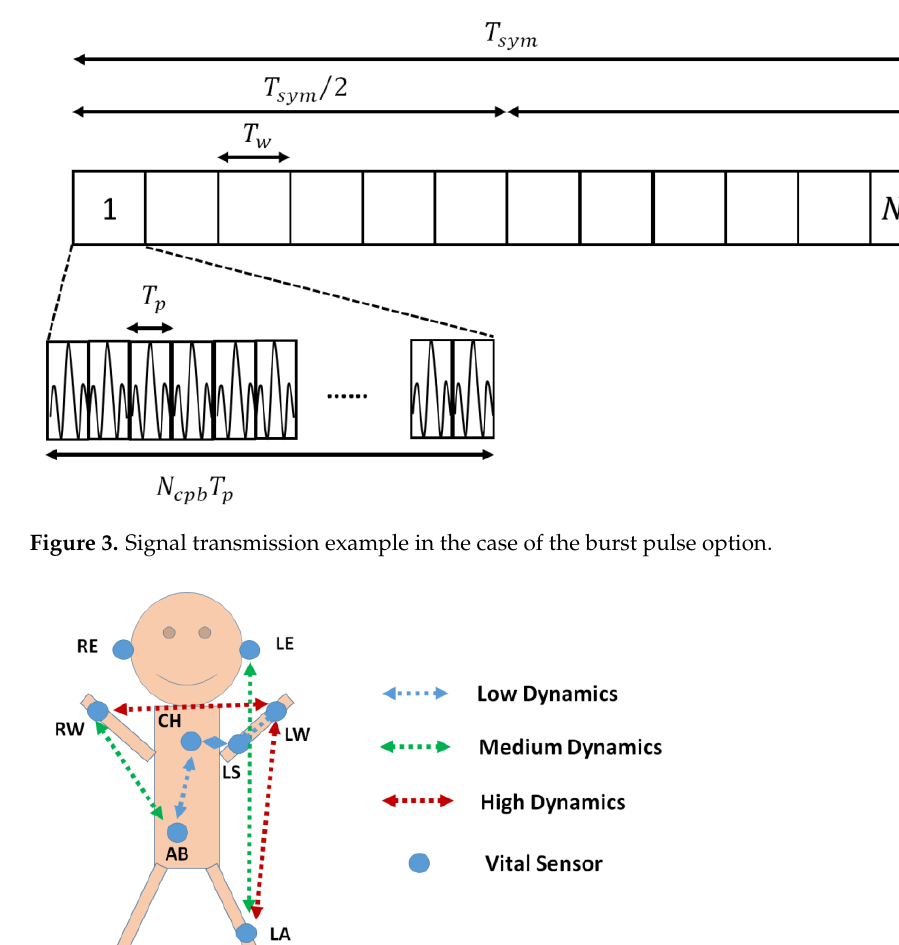
Figure 3. Signal transmission example in the case of the burst pulse option.